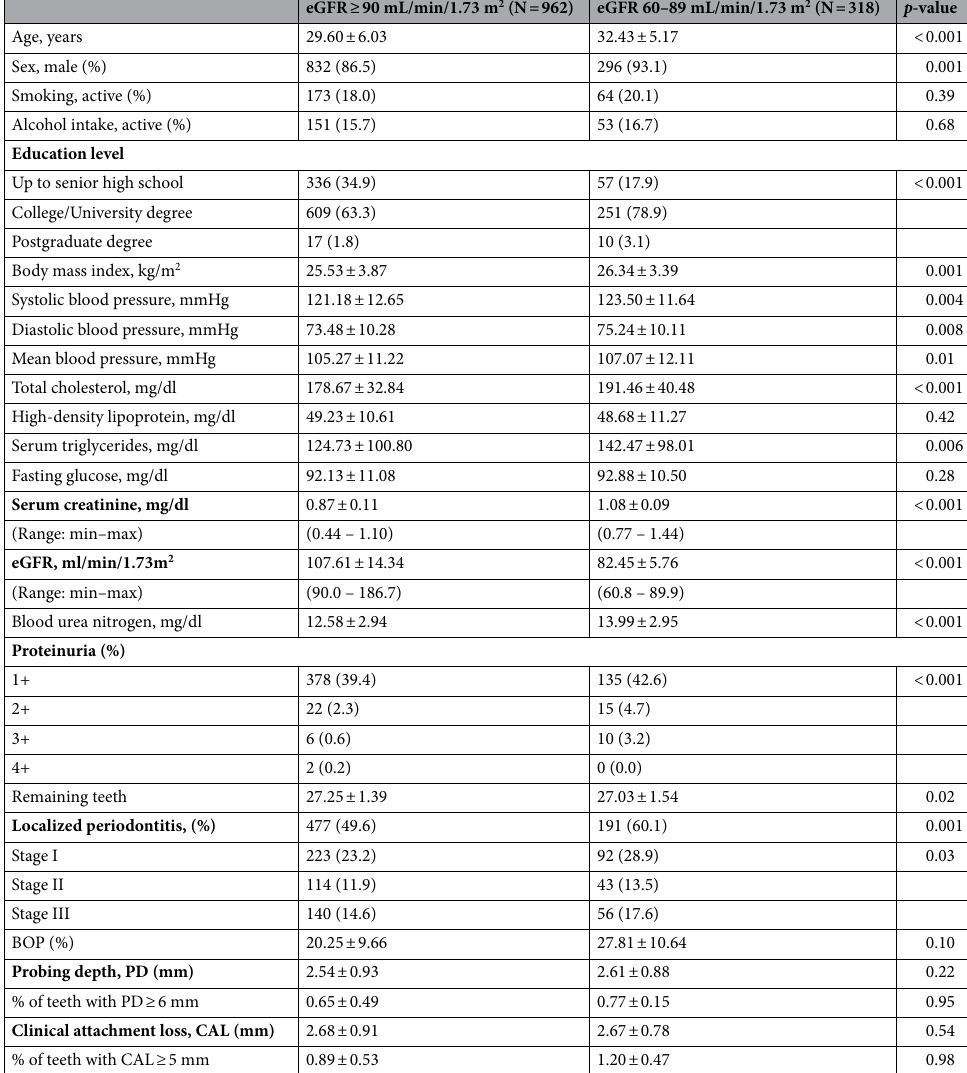
Table 1. Demographic and clinical characteristics of the study population (N = 1280). Continuous variables are expressed as mean ± standard deviation (SD), and categorical variables as N (%). eGFR estimated glomerular filtration rate, BOP bleeding on probing.